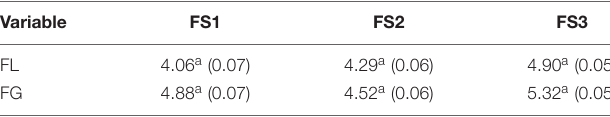
TABLE 2 | Adjusted marginal means (and SDs) for face source and frame (Study